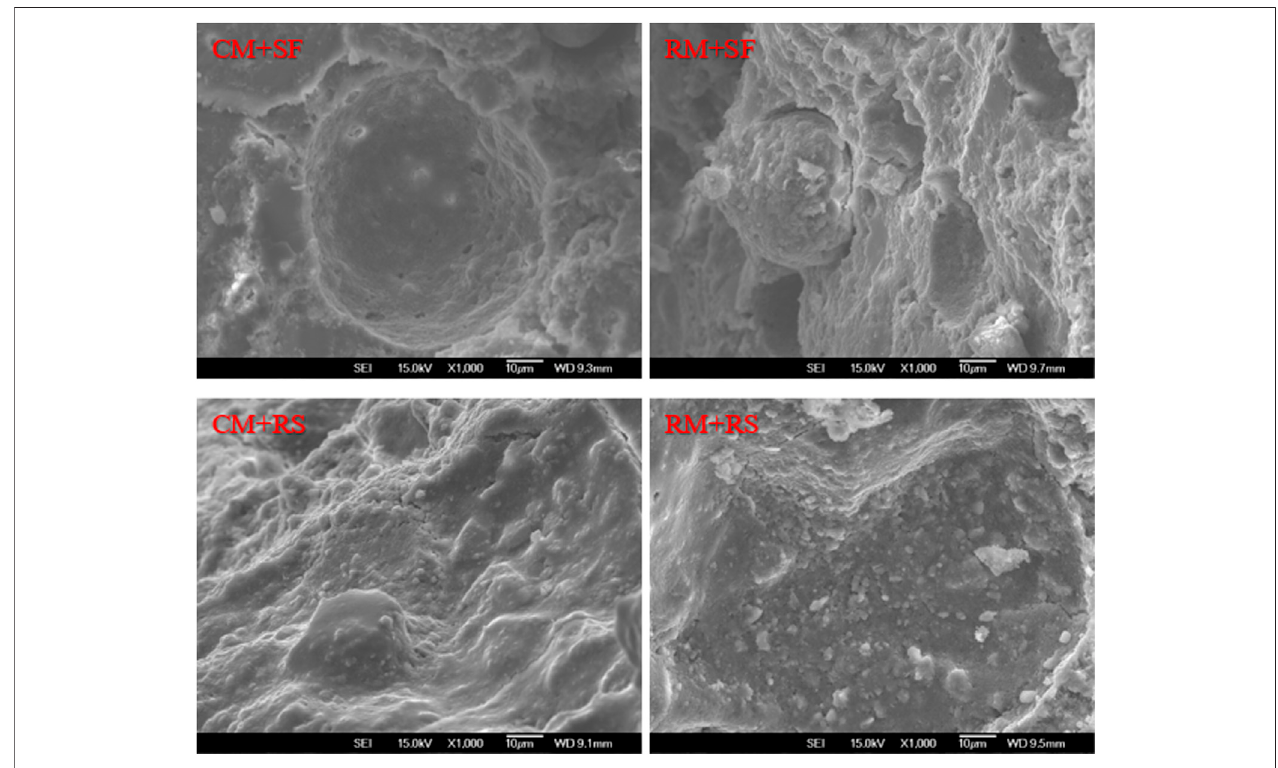
FIGURE 7 | SEM images of 28 days hydrated